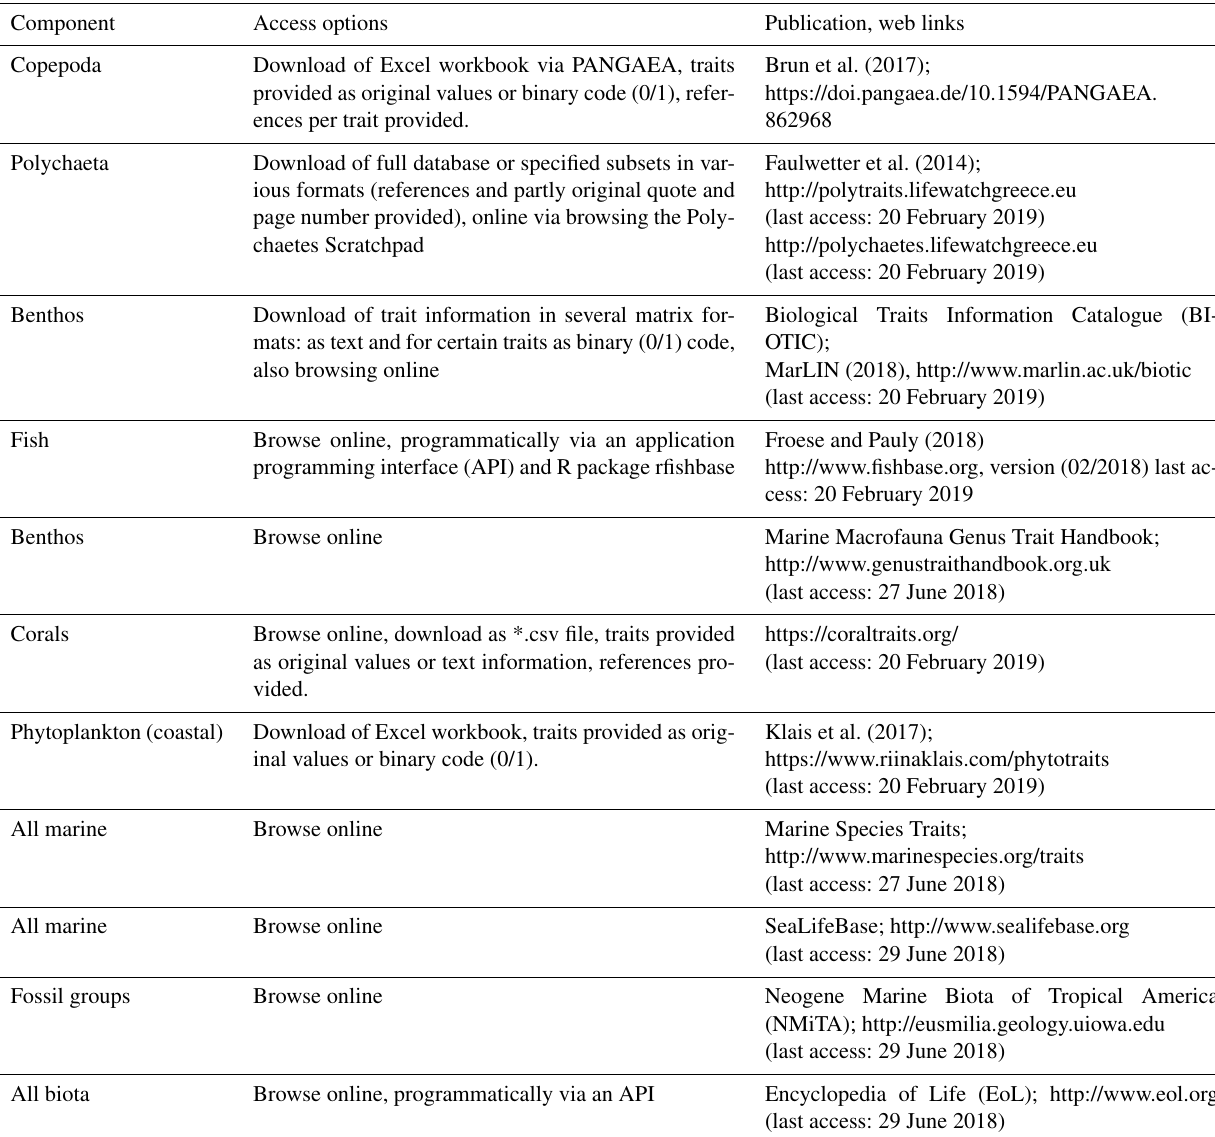
Table 1. List of marine trait databases or repositories. “Component” indicates the organism group targeted. “Access options” indicates in which forms the data can be accessed. References and web links are